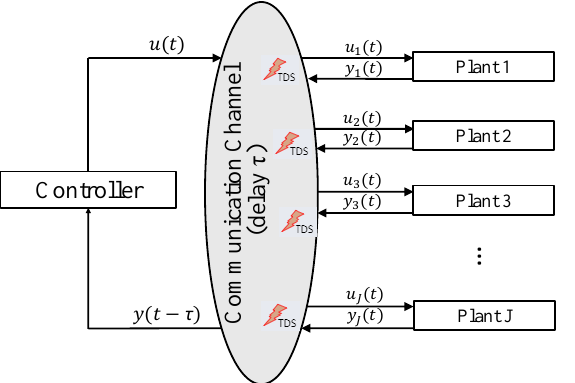
Figure 1. General diagram of a networked control system (NCS) with multiple plants under time- delay switch (TDS)